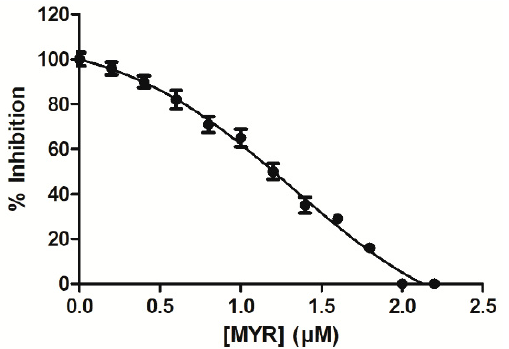
Figure 2. Concentration-response curve for the determination of IC50 value for the inhibition of hGSTA1–1 by MYR. The graph was produced using GraphPad Prism 5. The IC50 value corresponds to the concentration of inhibitor that gives 50% inhibition in the standard assay system with CDNB and